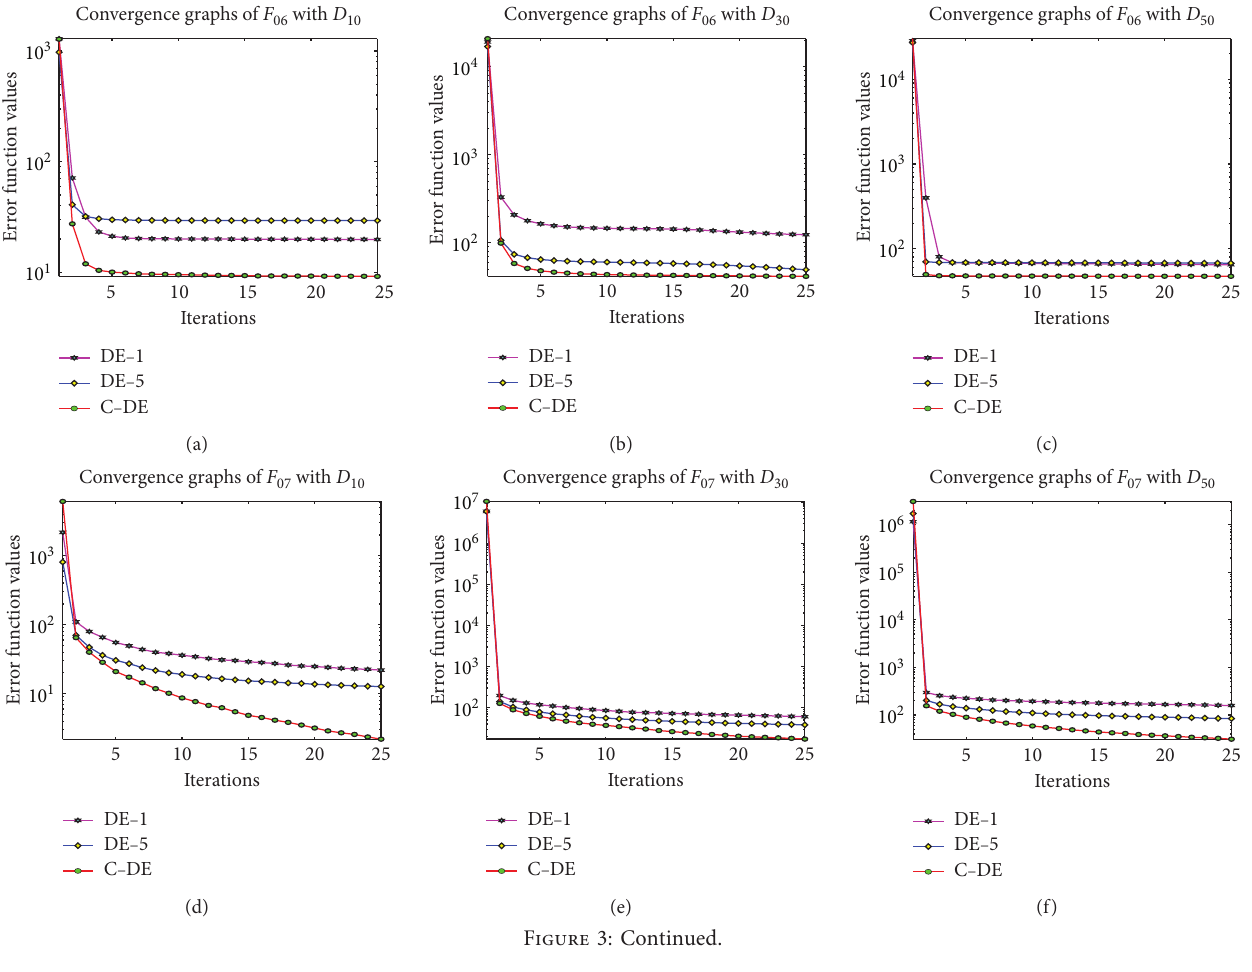
Convergence graphs of F 06 with D